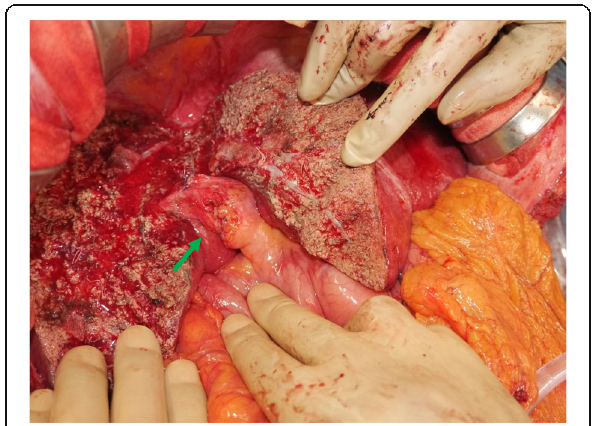
Fig. 3 Intraoperative findings of FSTG. Anterior segmentectomy was performed. Each branch of the hepatic artery, portal vein, and biliary duct were ligated together as the Glissonean bundle (so-called FSTG) (arrow)